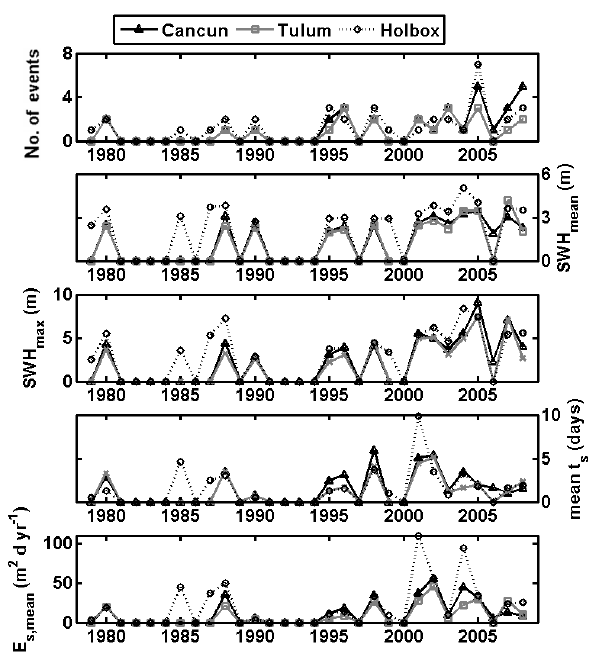
Figure 10. Time series of the number of TC events, SWH mean and SWH max , mean duration and E s , mean for the Holbox, Cancun and Tulum